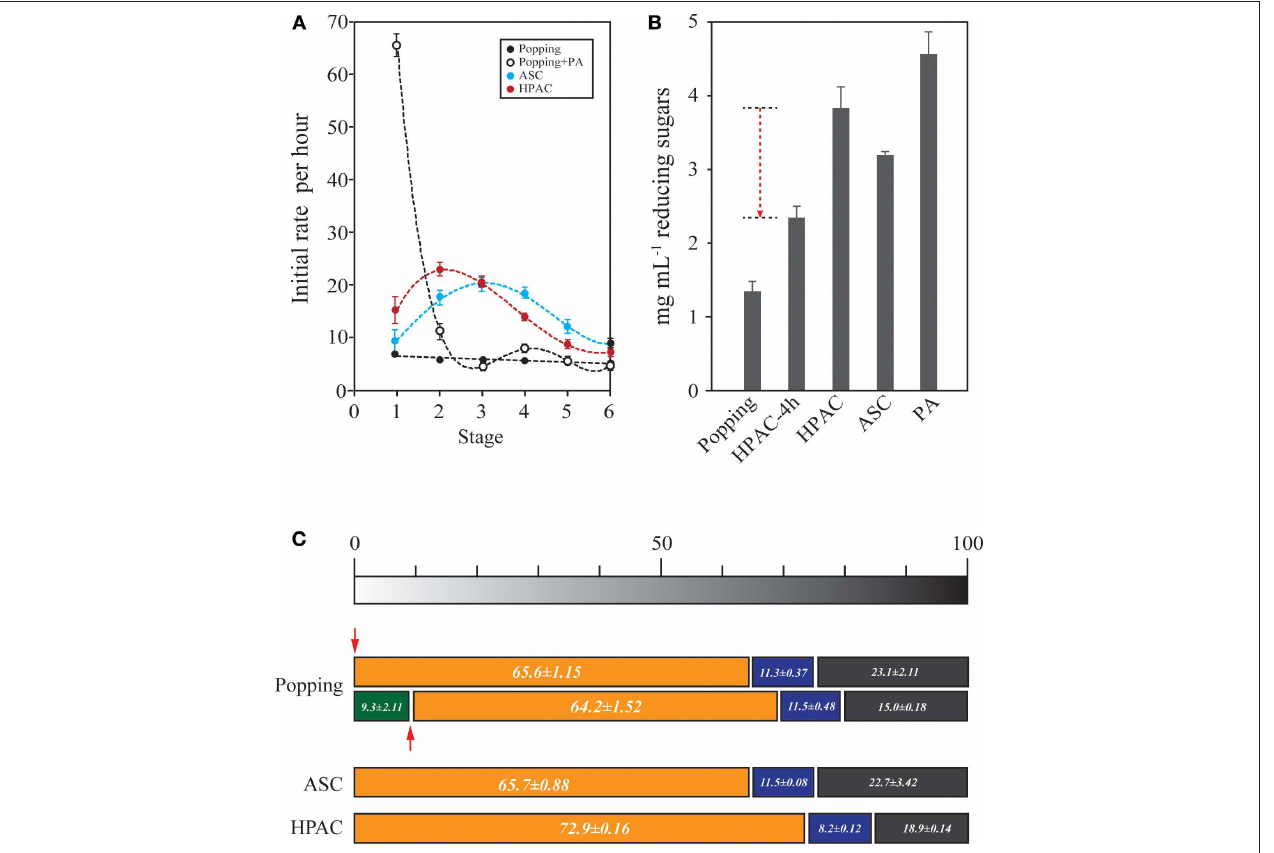
FIGURE 1 | Determination of the ratio of recalcitrant cellulose in oak wood. (A) To estimate the cellulose structural retardation during the enzymatic hydrolysis, re-hydrolysis was performed with 1% (g v − 1 ) PA, ASC, and HPAC pretreated oak. Each stage was conducted with 3.5 FPU at 50 ◦ C for 1h. A new stage was started with the remaining solid fraction after the hydrolysis with fresh enzyme. The hydrolysis patterns during re-hydrolysis were shown to be little different between HPAC- and ASC-pretreated oak ( p = 0.823 ), but the significant hydrolysis rate were appeared at the first stage of phosphoric acid treated oak ( p = < 0.001 ). The most retardation during the hydrolysis occurred in popping-pretreated oak ( p < 0.050 ). (B) To investigate the end-product inhibition at the early stage, the sum of reducing sugars up to the 4th stage (popping, HPAC, ASC, and PA) in (A) was compared with the concentration of reducing sugars produced by the reaction over 4h (HPAC-4h). The red dotted arrow indicates reduction via end-product inhibition. (C) Determination of the cellulose structural retardation factor. Popping-pretreated oak was hydrolyzed for 1h (green bar). PA was treated for amorphogenesis (red arrow). The bars represent the cellulose types based on the data of (A) . The cellulose was sorted into three types: readily hydrolysable (orange bar), mid-hydrolysable (blue), and hardly hydrolysable (dark gray).